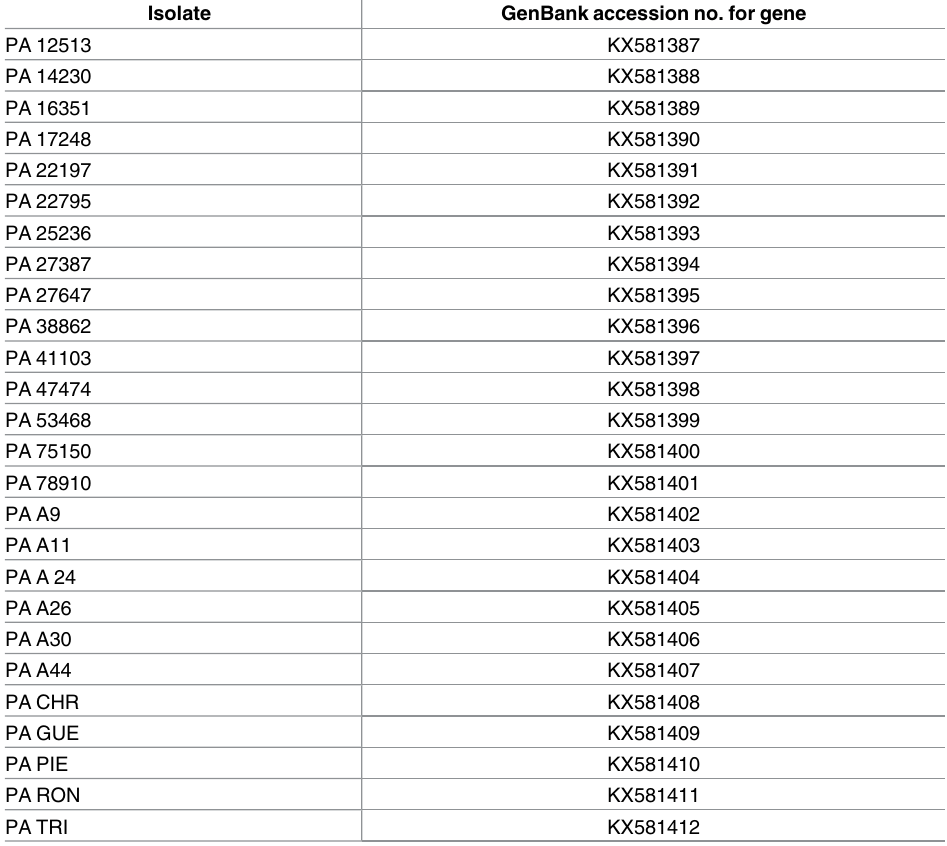
Table 4. GenBank accession numbers of CAMP factor 1 genes from all the P . acnes isolates studied